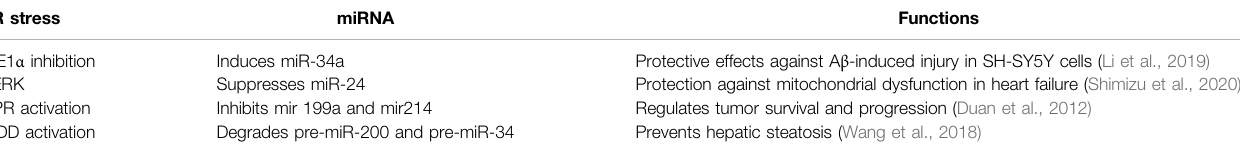
TABLE 2 | ER stress-mediated miRNA regulation during age-related diseases.